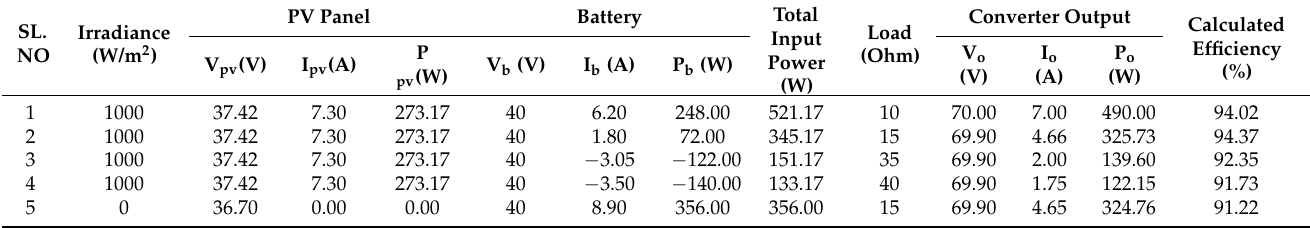
Table A2. Calculation of efficiency at various